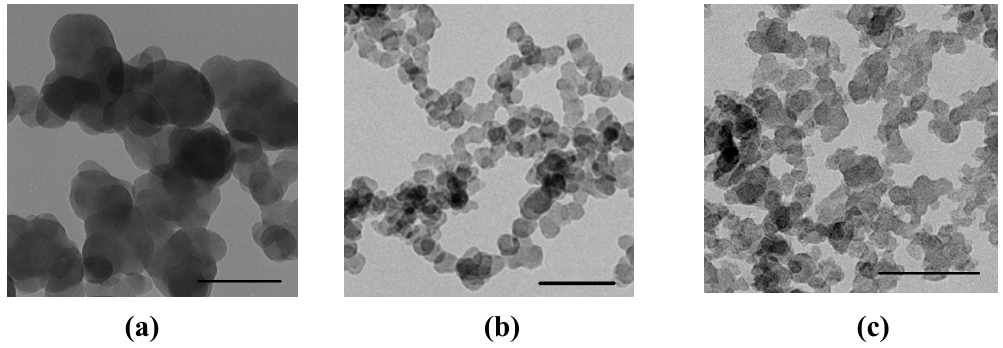
Figure 1. TEM images of carbon black ( a ) PG; ( b ) S160; ( c ) P90. Scale bar = 100 nm.